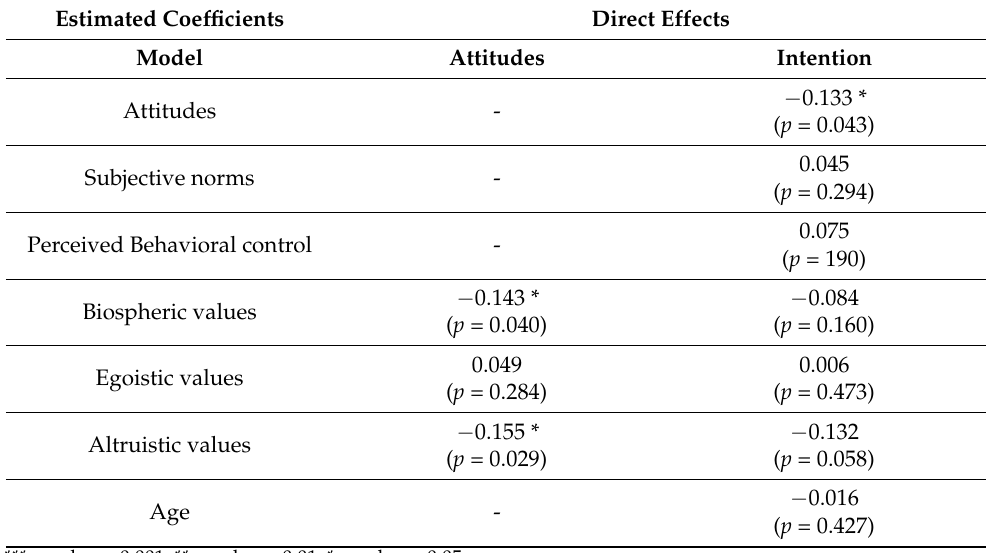
Table 7. Differences in path coefficients by gender (females versus males).